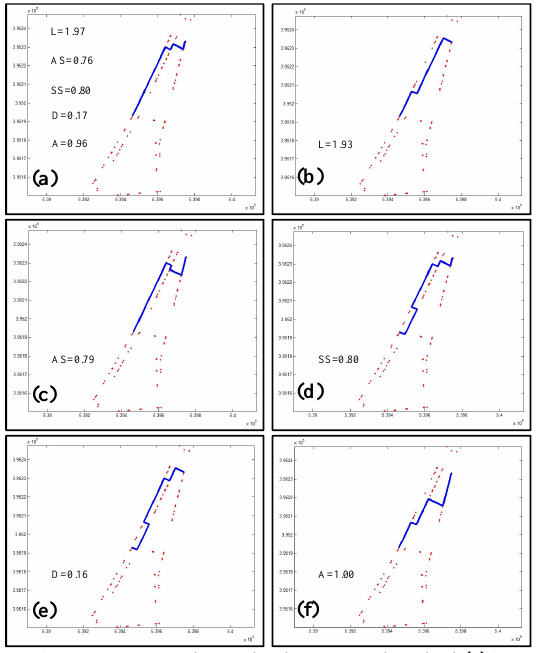
Figure 4. Suggested route by the proposed method (a) in comparison to the best routes in terms of length (b), accident safety (c), social safety (d), difficulty (e) and attraction